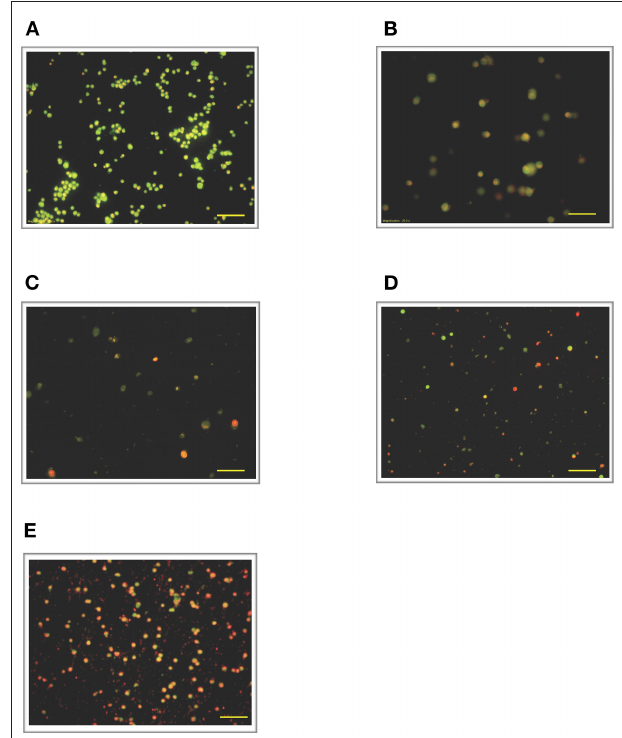
FIGURE 6 | Acridine orange and propidium iodide nucleic acid binding dyes in LPS-stimulated cells. Cells were stimulated with 9 µ g/mL LPS for (A) . Control, (B) . 12, (C) . 24, (D) . 48, and (E) . 72h. Cells were stained with AO/PI to examine their morphological changes, where the green color represents AO, which stains live and dead nucleated cells while the red color represents PI, which stains dead nucleated cells. Representative fluorescence images from inverted fluorescence microscope. Field of views for each time point from three independent experiments. The cells lost membrane integrity with yellow to orange color change, indicating pre-early and early apoptosis, and orange-reddish, indicating late apoptosis. Pictomicrographs were taken with original magnification (10 × ); the scale bar represents 100 µ m.